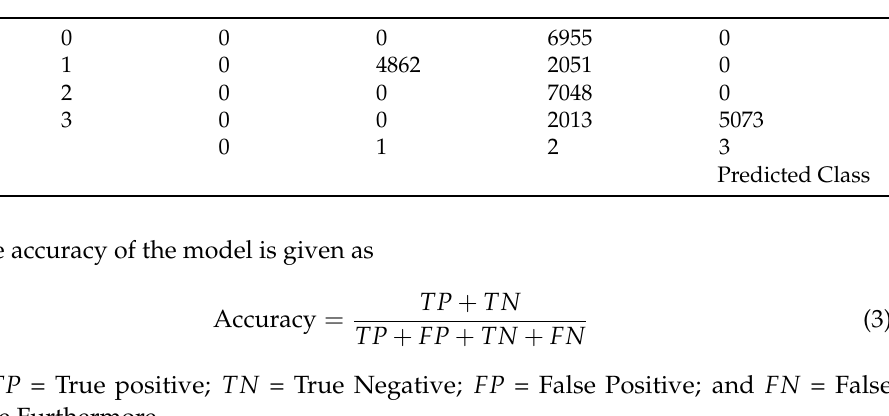
Table 5. Confusion matrix for the fault classification.